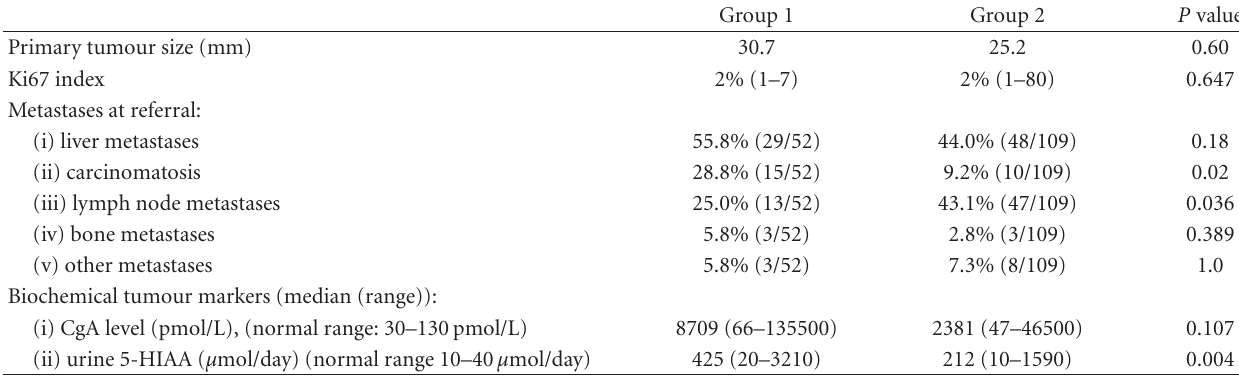
Table 2: Tumour characteristics.